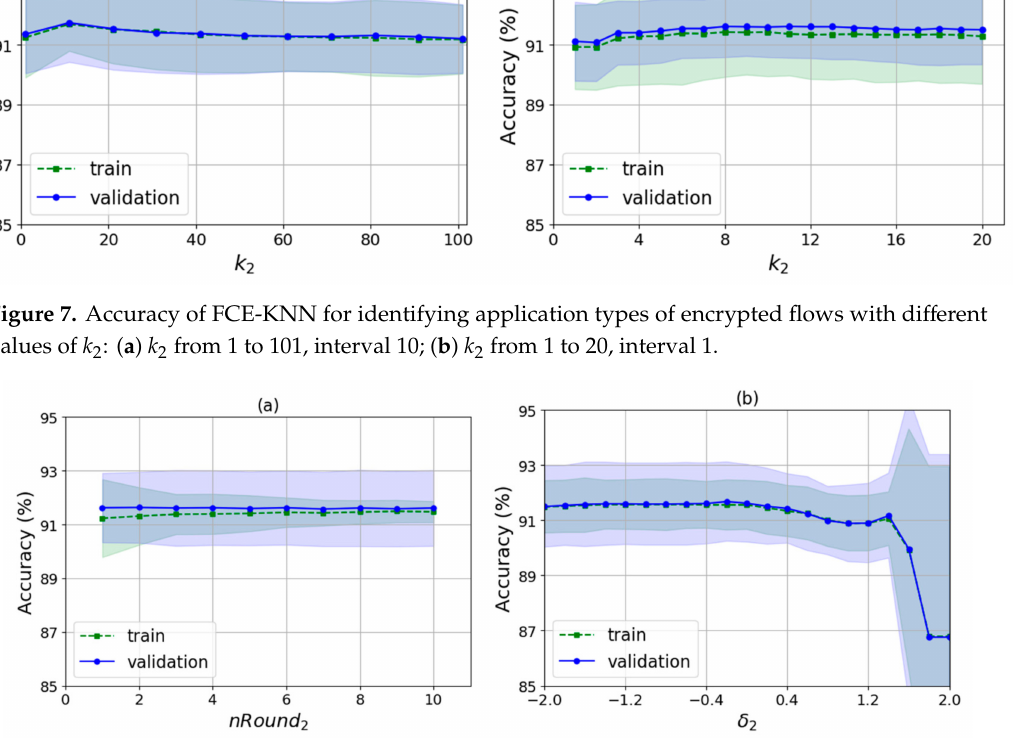
Figure 8. Accuracy of FCE-KNN for identifying application types of encrypted flows with di ff erent values of nRound 2 or δ 2 :( a ): Accuracy under di ff erent nRound 2 ; ( b ) Accuracy under di ff erent δ 2 .